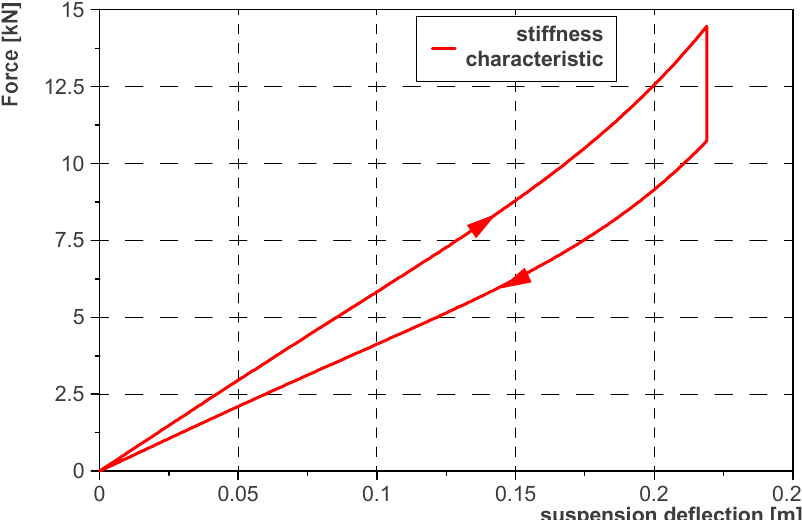
Figure 7. Stiffness characteristic of the package of logarithmic spiral springs when the pressure is equal to 0 bar.